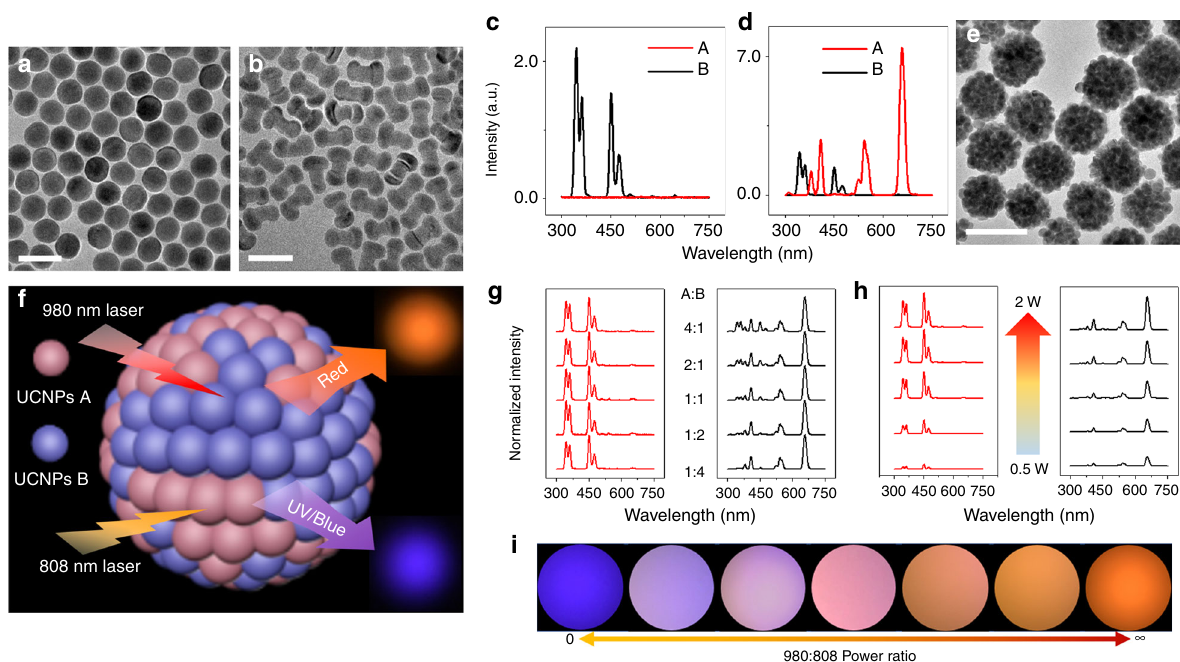
Fig. 1 Orthogonal excitation superballs with mixed UCNPs A and B. TEM images of UCNPs A ( a ) and UCNPs B ( b ). 808 nm ( c ) laser and 980 nm laser ( d ) excited upconversion emission spectra of cyclohexane solutions at room temperature (25 °C) comprising A (red line) and B (black line) with same concentration. e TEM images of OP-SBs. f Schematic illustration of OP-SBs with luminescent photos taken by smart phone camera. g Normalized 808 nm laser (left) and 980 nm laser (right) excited upconversion emission spectra of superball aqueous suspension at room temperature (25 °C) with different mixing ratio between A and B. 808 and 980 nm laser power (1 W) are kept same throughout the measurement. h 808 nm laser (left) and 980 nm laser (right) excited upconversion emission spectra with increasing laser power of superball (A:B = 1:1) aqueous suspension at room temperature (25 °C). i Smartphone images of OP-SBs (A:B = 1:1) pattern under different 980 nm:808 nm laser power ratio. Scale bar: 50 nm for a , b , 200 nm for e . UCNPs A, NaYF 4 : 60%Yb, 20%Gd, 2%Er@NaLuF 4 : 25%Y; UCNPs B, NaYF 4 : 30Yb, 0.5%Tm@NaYF 4 : 10%Yb@NaNdF 4 :